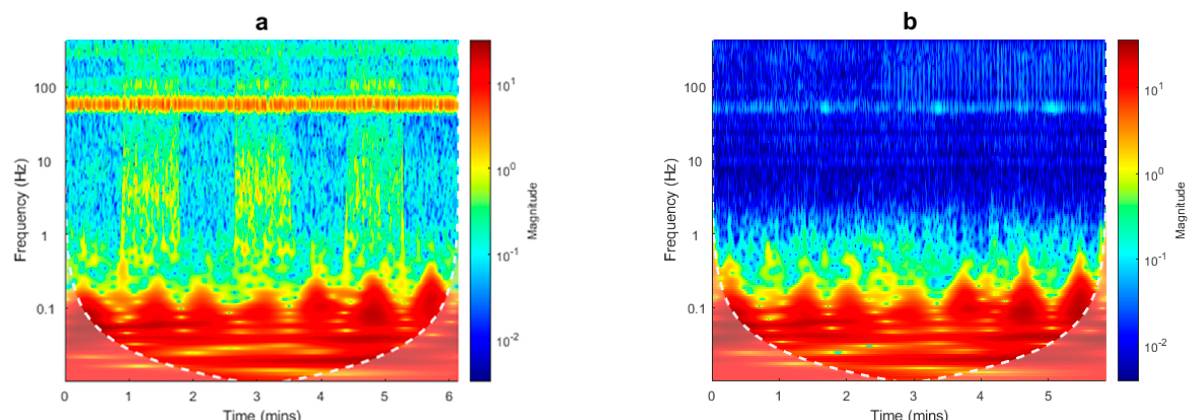
Figure 4. Spectral analysis of UAV data. ( a ) Scalogram of F0.5 dataset; ( b ) scalogram of F3.0 dataset. Edge effects in the computation of the spectra may be significant in the dimmed area below the dashed white line.